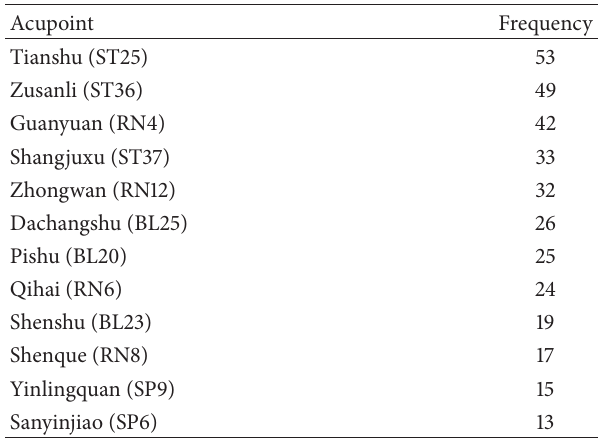
Table 3: Statistical analysis of the use of moxibustion. Table 4: Statistical results of commonly used acupoints.